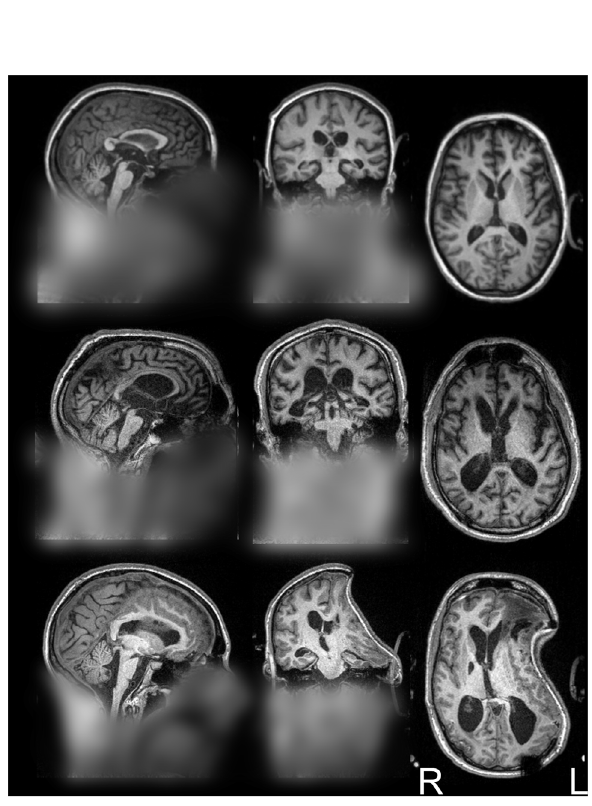
Fig. 3. Sample patients’ full head images. Orthogonal projection view of the original full head images for the three patients employed in Fig. 2. From top to bottom the images exemplify patient with relatively low, medium, and high brain pathology – relative to this cohort of patients. (Images are displayed in radiological convention; blurring added to protect the privacy of the patients).